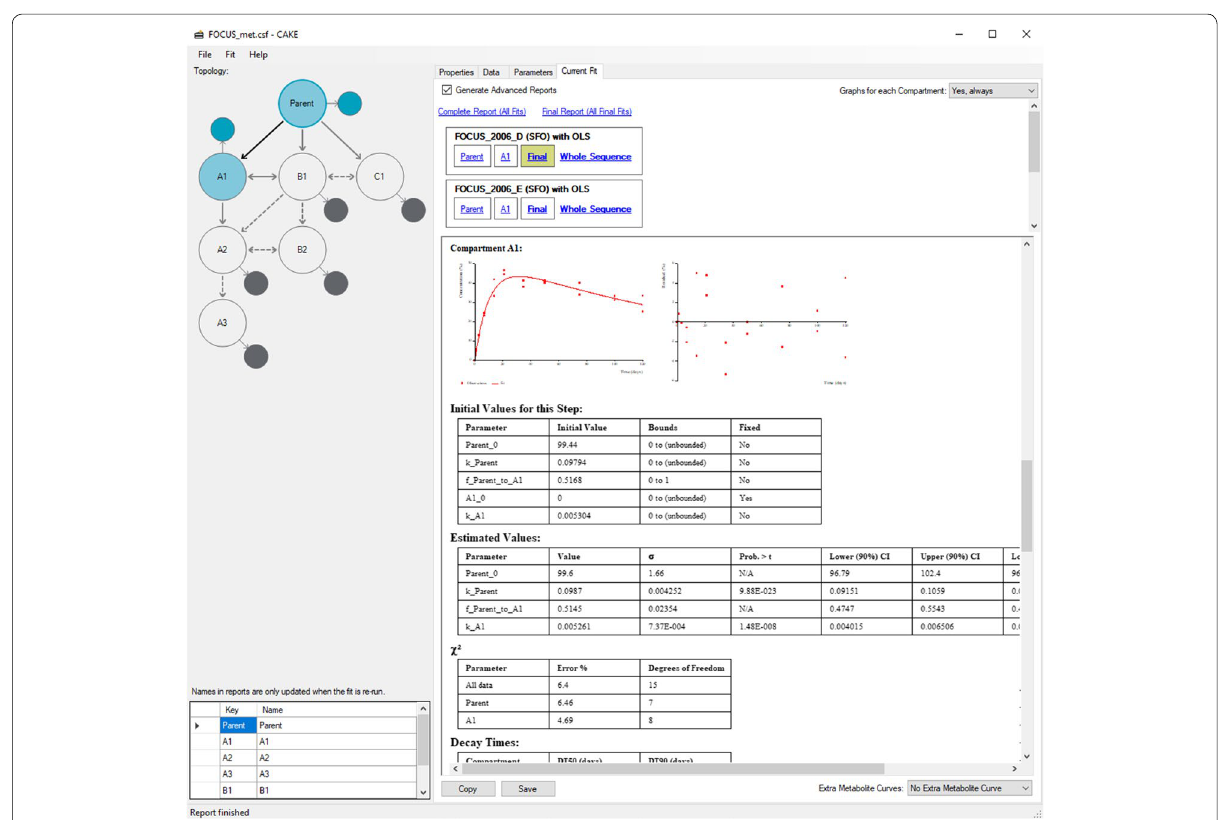
Fig. 3 Screenshot of CAKE 3.3 The model definition is shown on the left and part of the summary report with a plot and some numerical results on the right